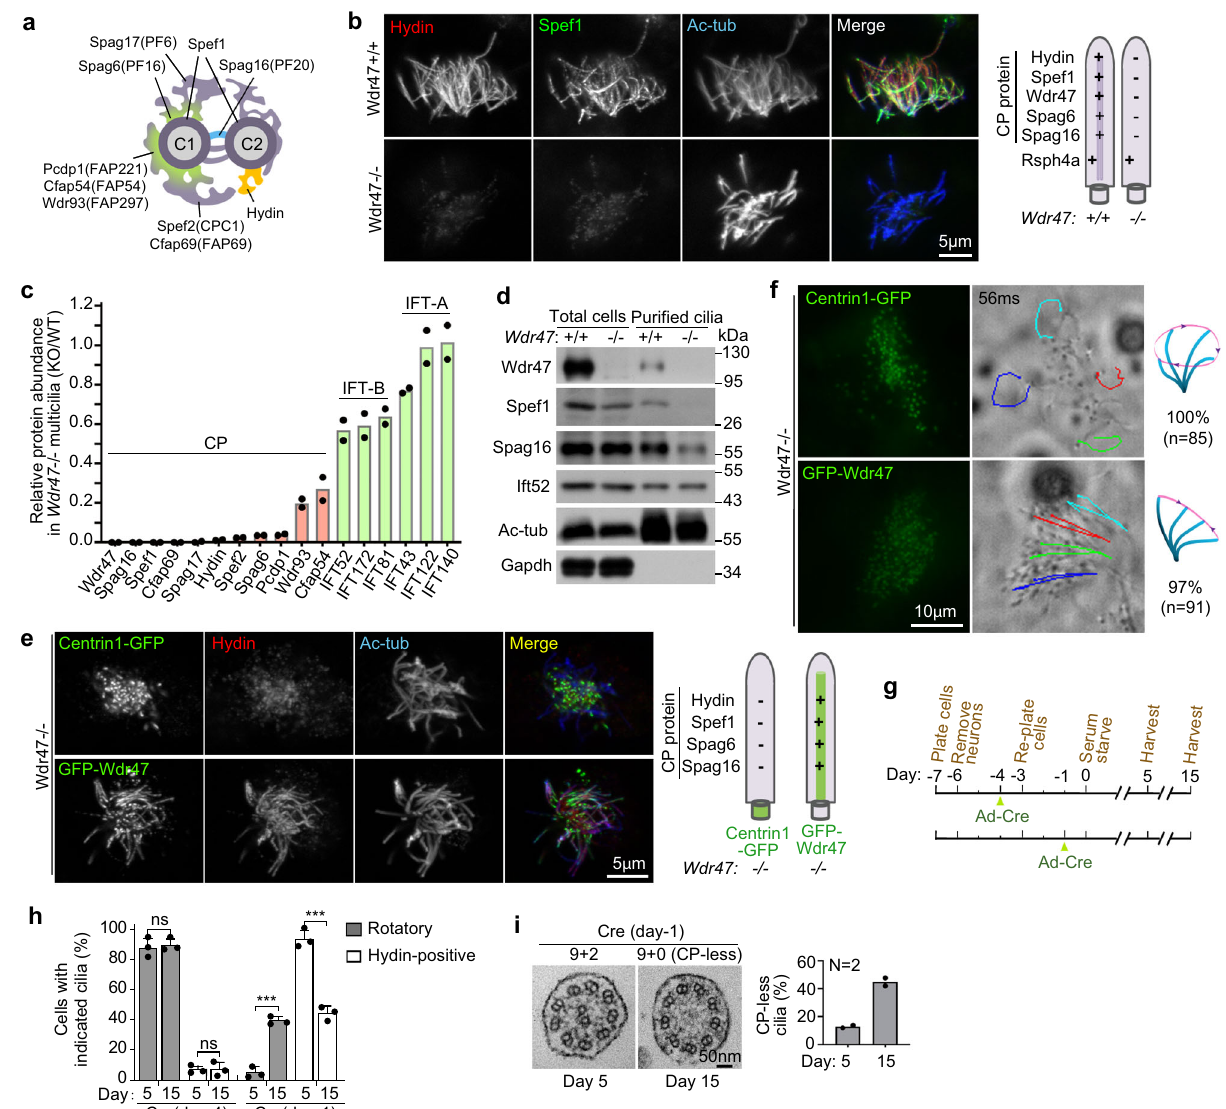
Fig. 2 Wdr47 is required for both ciliary localization of CP proteins and CP maintenance. a Diagram for detailed CP locations of the indicated